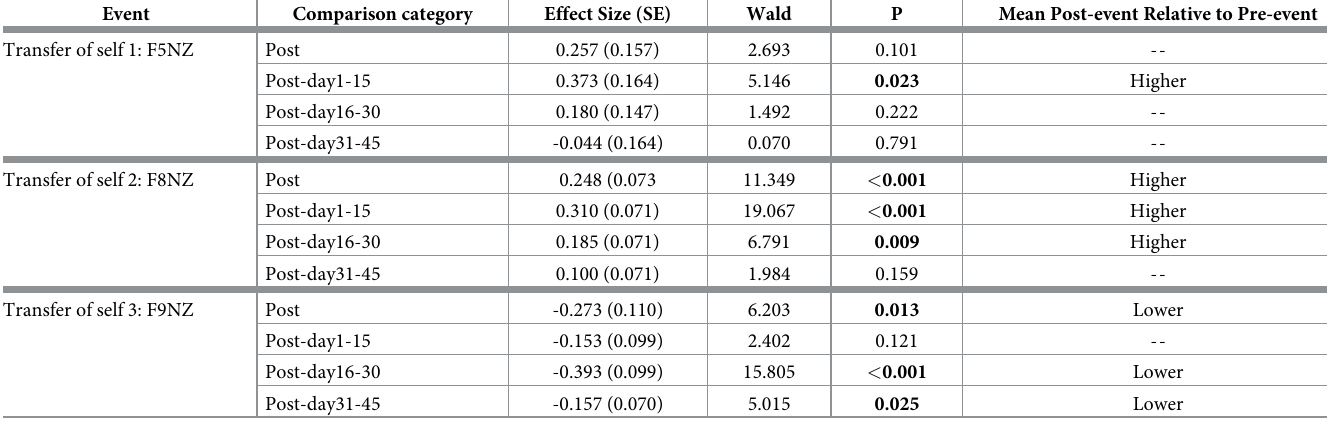
Table 7. Transfer of self as a predictor of adrenal GC activity. Fixed effects, effect size with standard error (SE), Wald statistic, and p-value from GLMMs, and whether the mean cortisol concentration post-event was higher or lower than pre-event. Degrees of freedom (df) was 1 in all pair-wise comparisons.